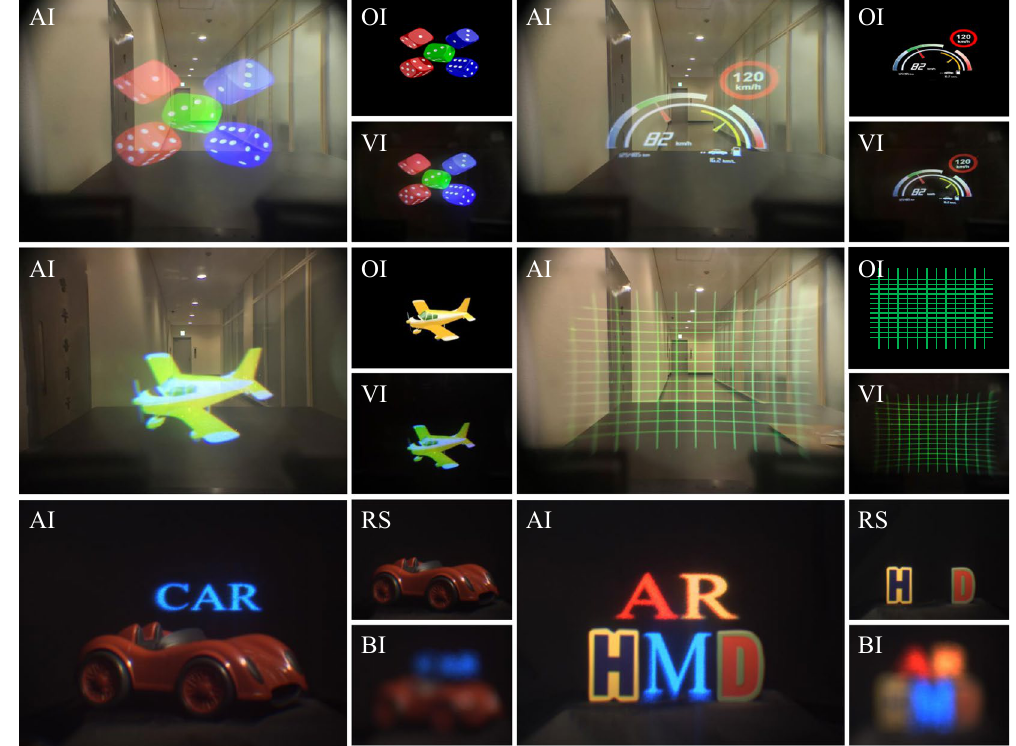
Figure 7. Experimental results of proposed AR-HMD system using IMACL. The dashboard, dices, stripes and planes are captured by the cell phone camera (Supplementary Video 1). The augmented reality image (AI) is shown and the original image (OI) and the virtual image (VI) only are also shown. The letters are captured by the CCD. The real world scene (RS) and the blurred image (BI) are shown. The rendered airplane image has